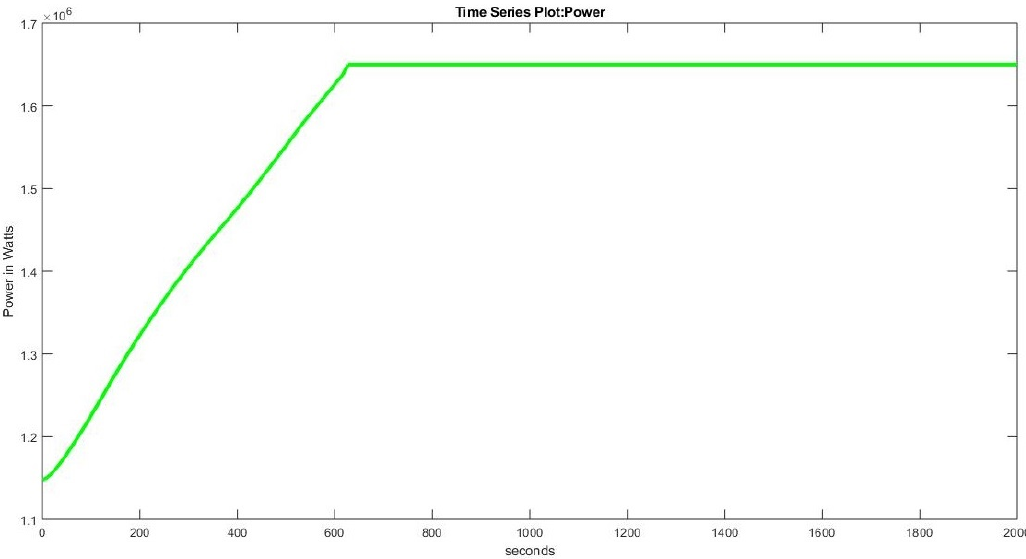
Figure 8. Power level in normal operation and desired power of 1.65 MW.